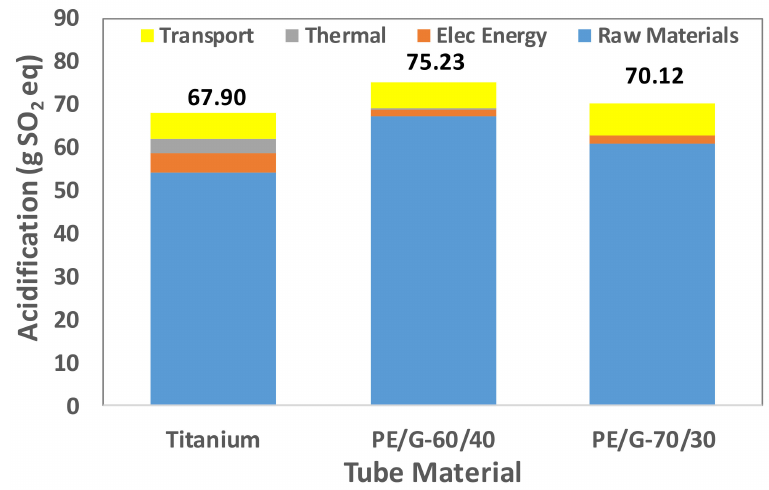
Figure 11. Acidification for titanium and polymer tubes.